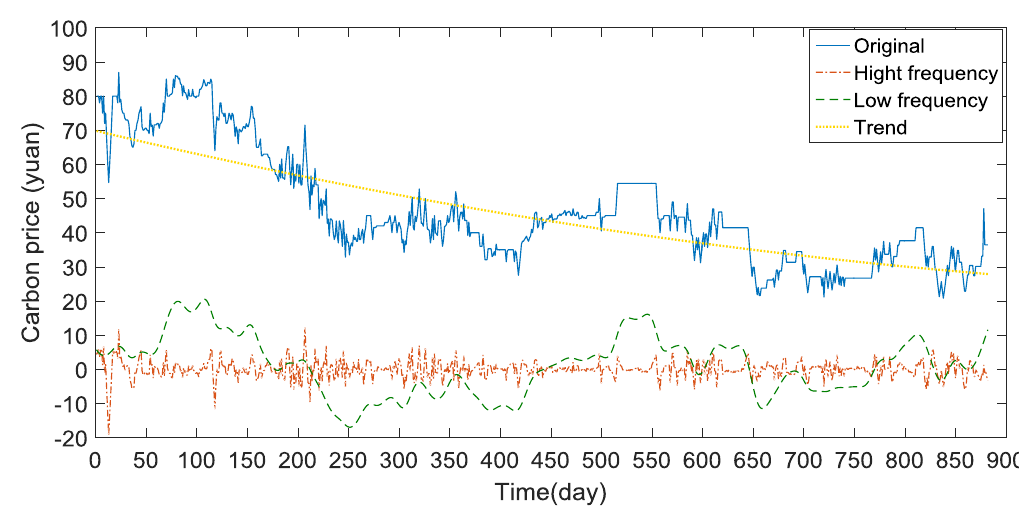
Figure 4. The mean of the IMF’s K index.